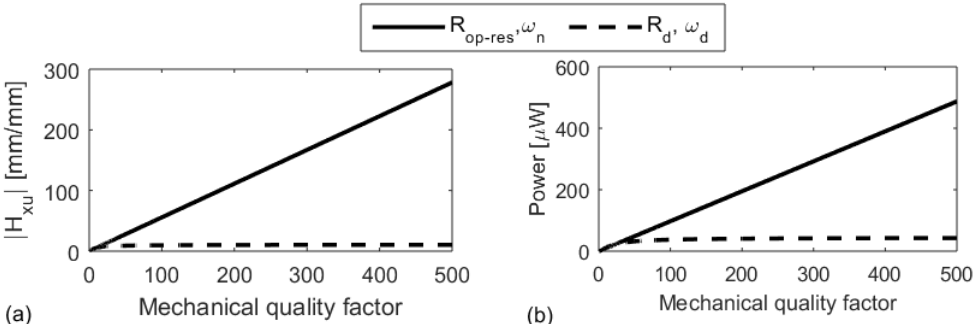
Figure 8. The impact of the quality factor on ( a ) the transfer function and ( b ) the power output at input excitation level of u = 0.8 µm.